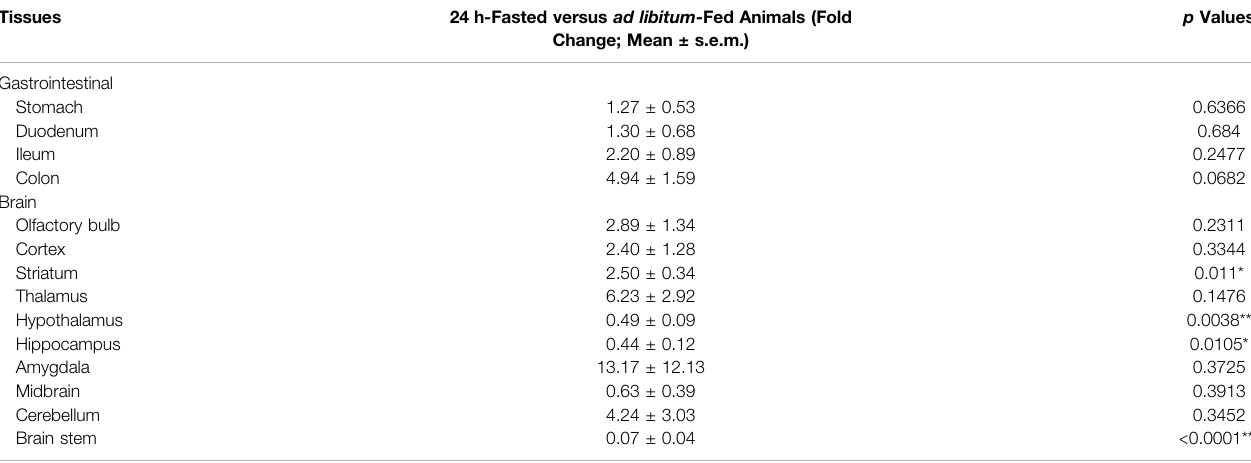
TABLE 1 | The relative NUCB2 mRNA expression levels between 24 h-fasted versus ad libitum- fed S. murinus.